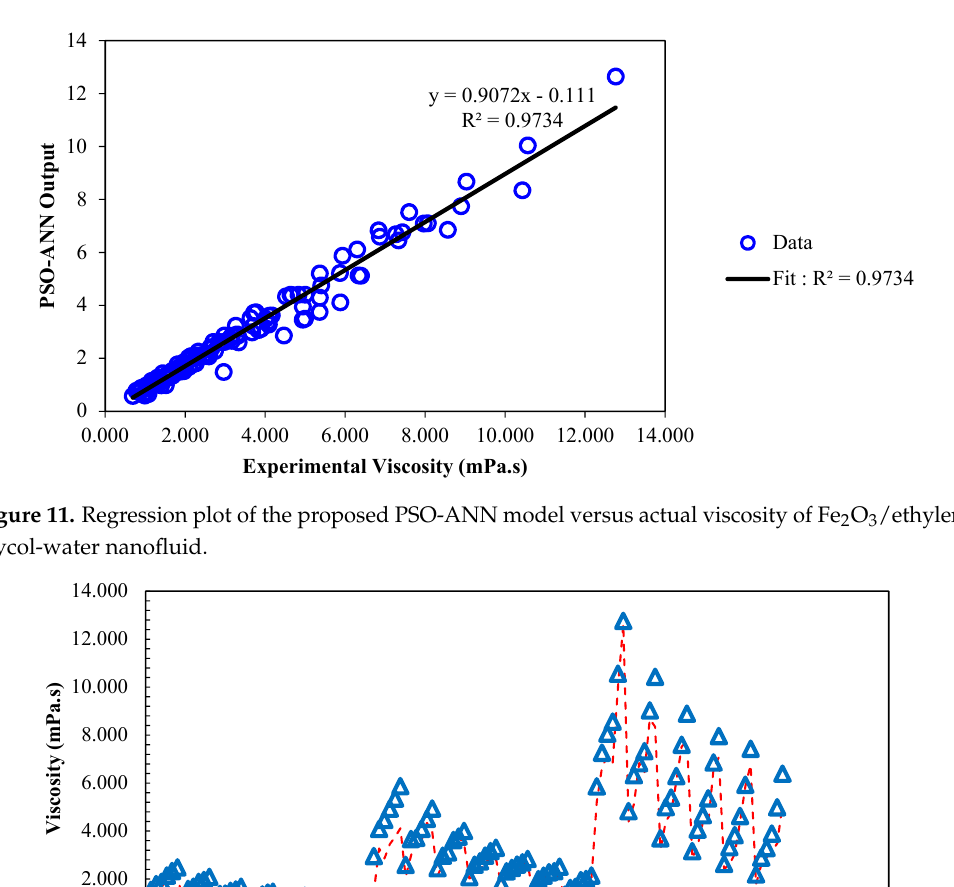
viscosity of (cid:1832)(cid:1857) (cid:2870) (cid:1841) (cid:2871) /ethylene glycol ‐ water mixture determination. Statistical Parameter LSSVM PSO ‐ ANN